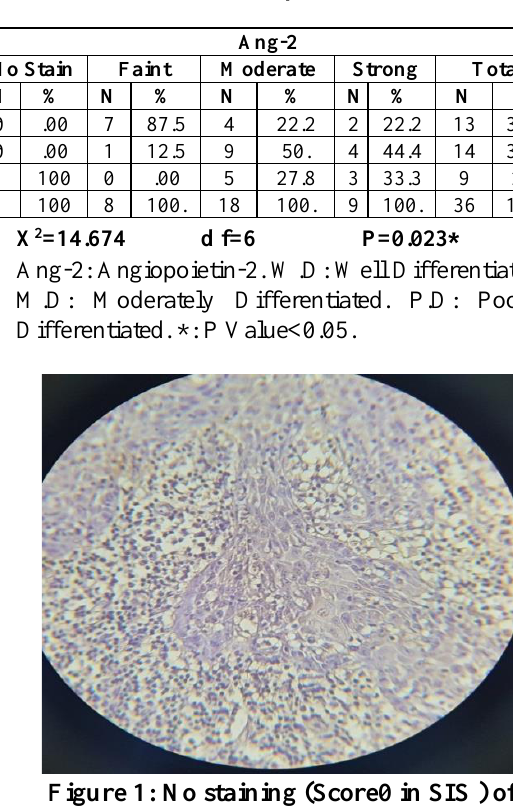
Table 8: The association between Ang-2 expression and the grade of the study sample.